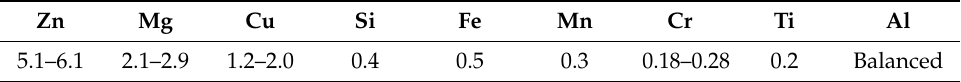
Table 1. The main chemical composition of 7075 in weight